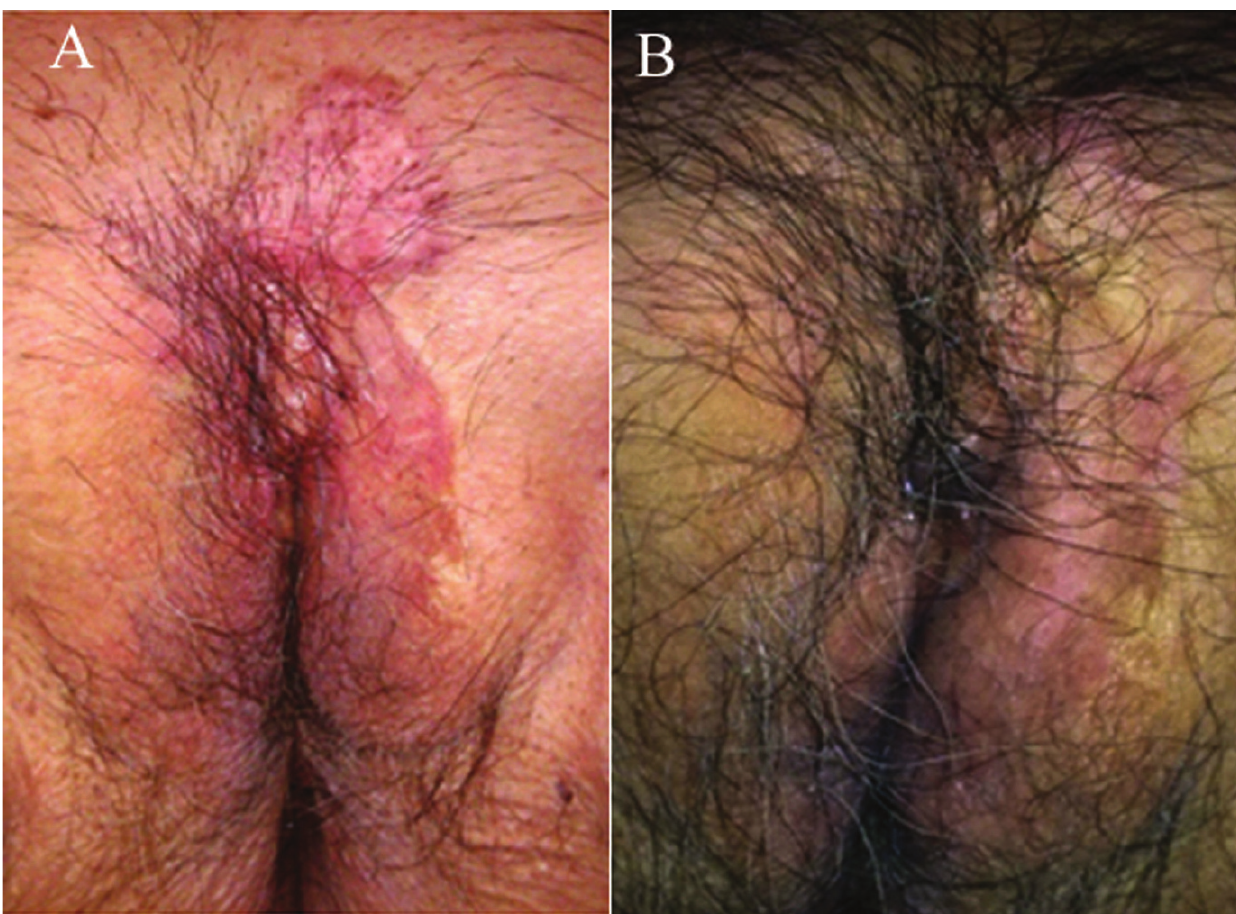
Figure 1 - Extramammary Paget’s disease. (A) Before treatment. Large hyperpigmented to pink plaque extending through the pubic area and left great labia. (B) After 25 weeks of treatment. Some biopsy scars are visible but there is no residual